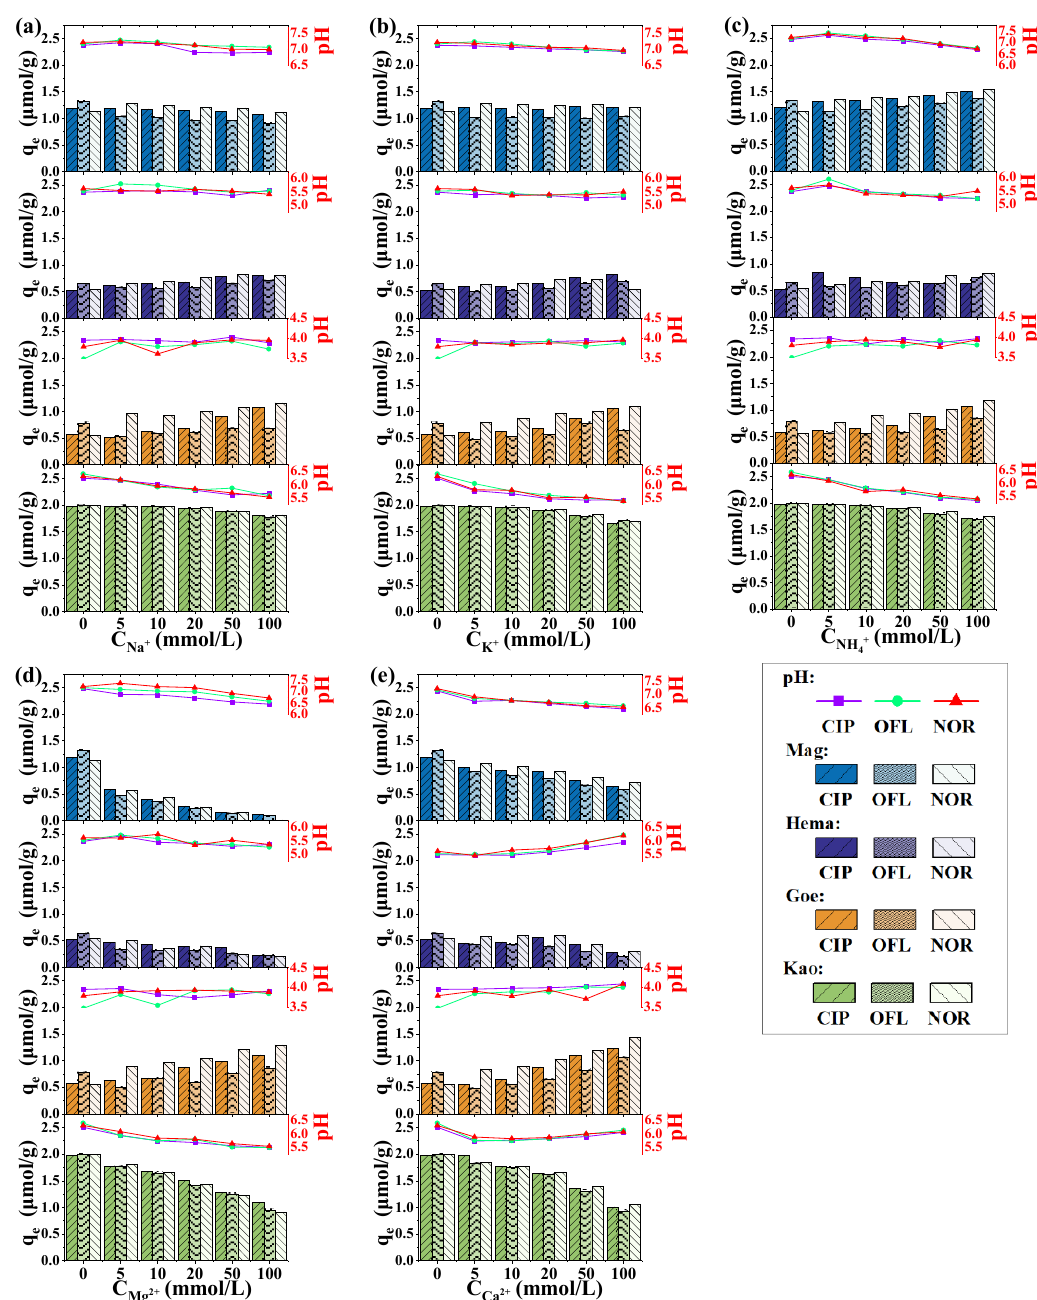
Figure 5. Effect of ( a ) Na + , ( b ) K + , ( c ) NH 4+ , ( d ) Mg 2+ , ( e ) Ca 2+ on the adsorption of CIP, OFL and NOR. Bars represent the adsorption amount, and points represent the ending pH of the solution after the adsorption. Conditions: [CIP] 0 = [OFL] 0 = [NOR] 0 = 10 μ mol/L, dosage of solids = 5 g/L.